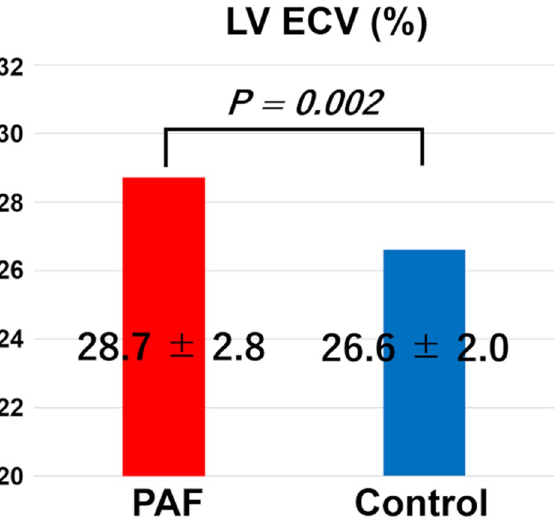
Figure 3. Differences in LV-ECV between the PAF and control groups. LV-ECV is significantly higher in the PAF group (28.7 ± 2.8%) than in the control group (26.6 ± 2.0%, P = 0.002).